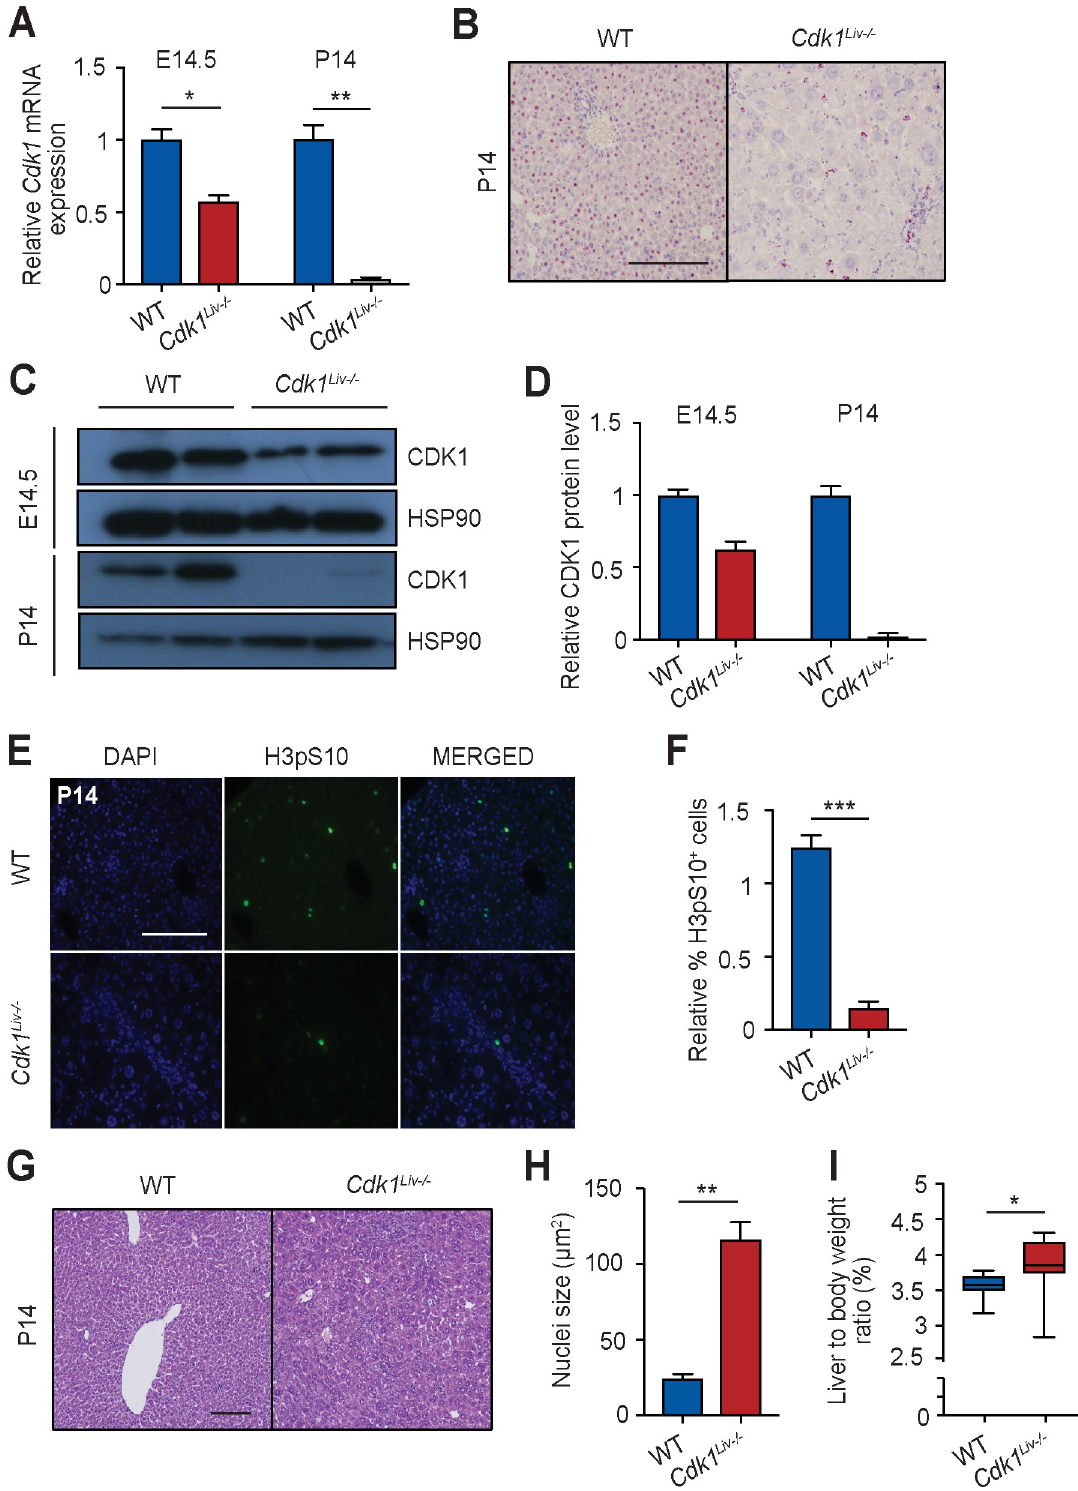
Fig 1. CDK1 is knocked-out by P14 in Cdk1 Liv-/- hepatocytes. (A) qPCR for Cdk1 mRNA expression in pre-natal hepatoblasts (E14.5) and post-natal hepatocytes (P14) (n = 3 mice per genotype per time point). (B) Representative image of in situ hybridization for exon 3 of Cdk1 on liver sections using the BaseScope assay. (C) Immunoblot of lysates from hepatoblasts (E14.5) and hepatocytes (P14) probed